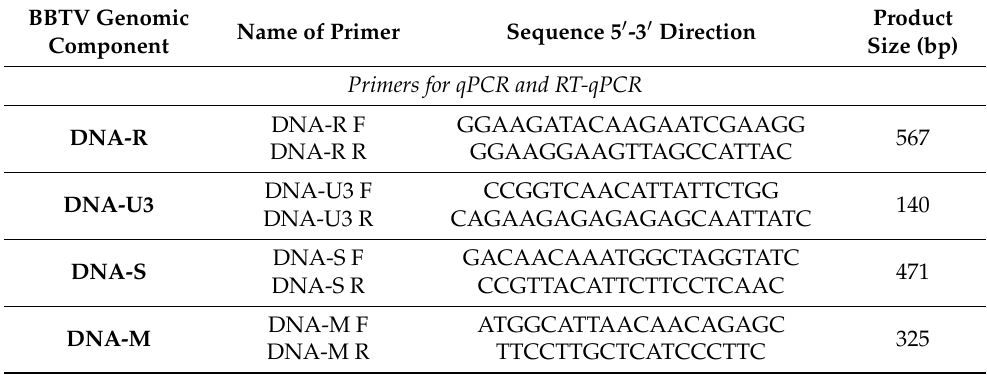
Table 1. Details of primers used to sequence BBTV genomic components from